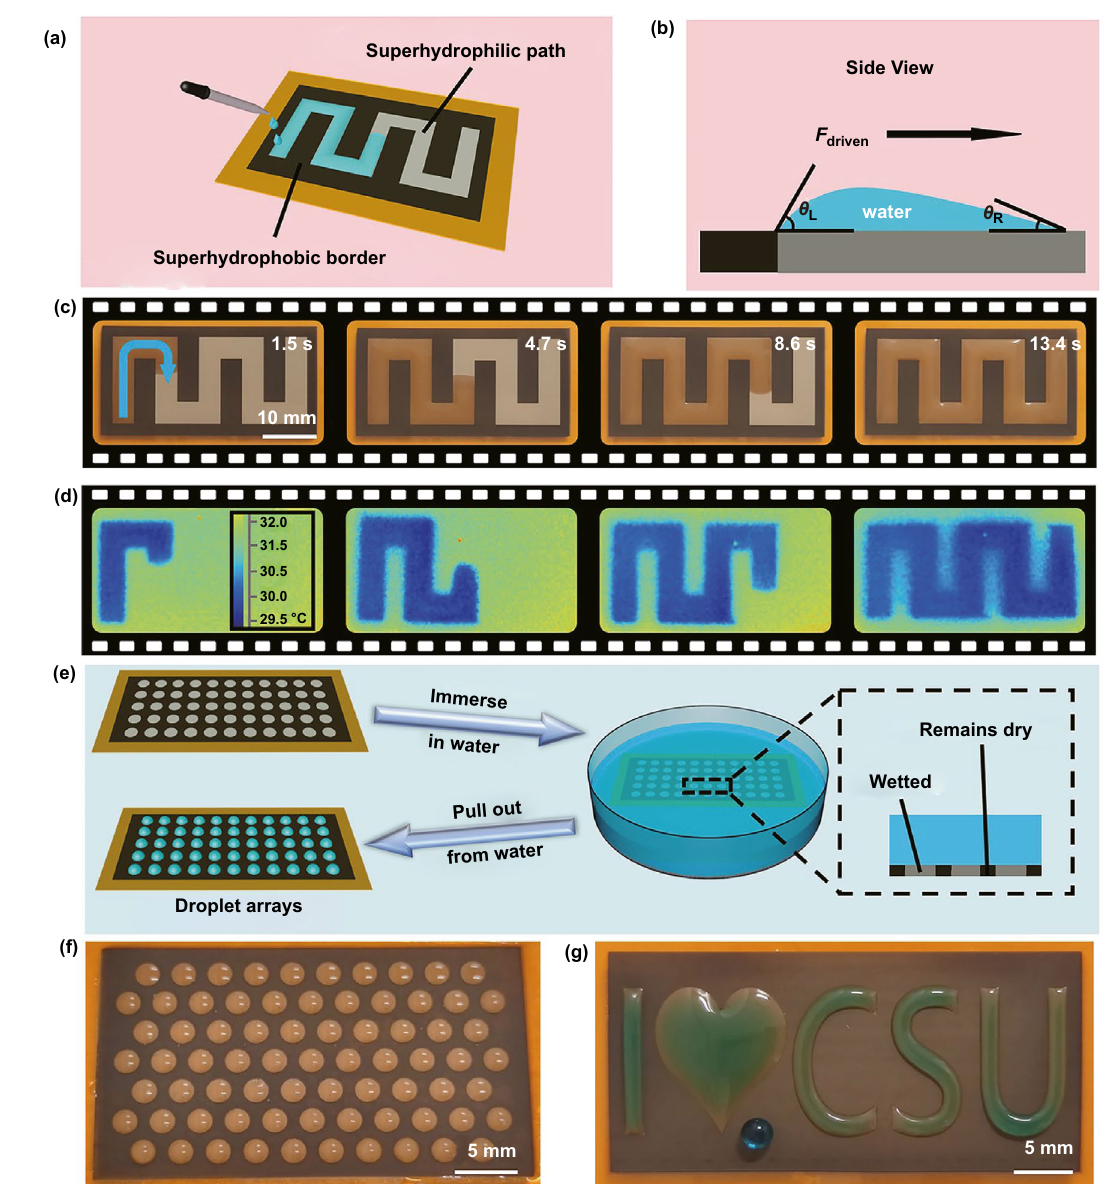
Fig. 4 a Schematic diagram of water transport on superhydrophilic path. b Qualitative mechanism of water transport on superhydrophilic path. c A series of optical photographs for water transport along superhydrophilic path. d Infrared images of water transport along superhydrophilic path. e Schematic diagram and mechanism illustration of the constructed process for the droplet arrays. f Optical photographs for the droplet arrays. g Optical photographs for the designed superhydrophilic–superhydrophobic patterns filled with water dyed with Methylene